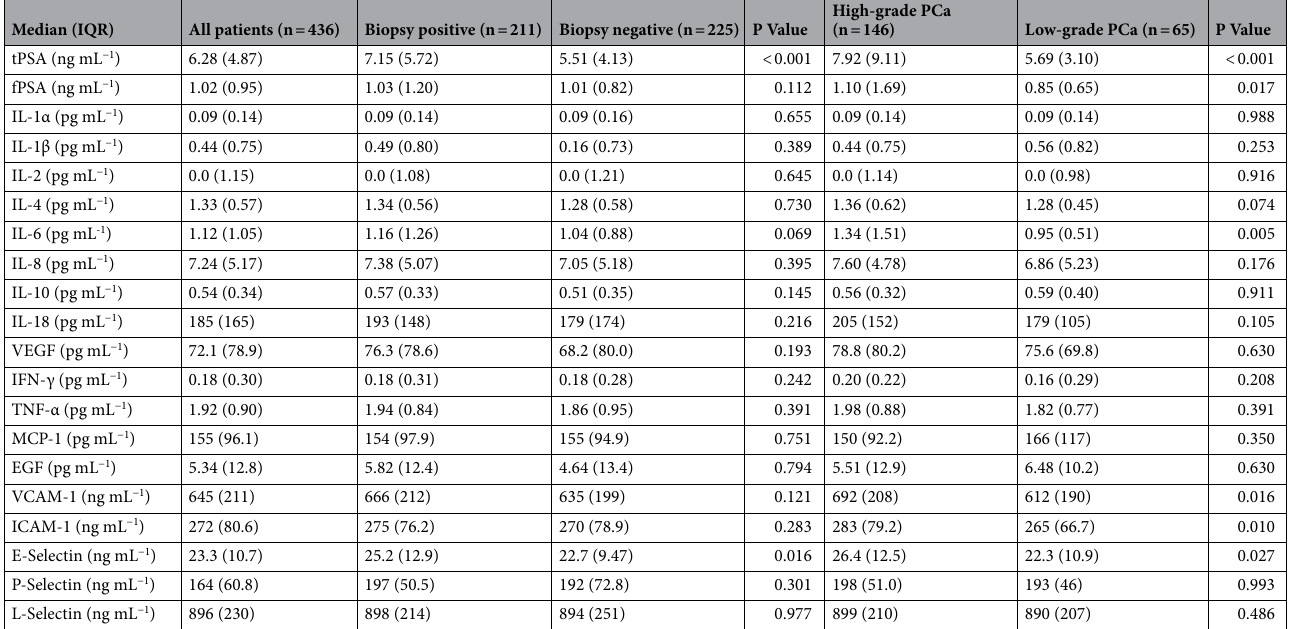
Table 2. Descriptive analysis of serum biomarkers (median and interquartile range) grouped by biopsy and grading outcomes. The p-value of Wilcoxon Rank test indicates whether the observed differences in median for each biomarker is